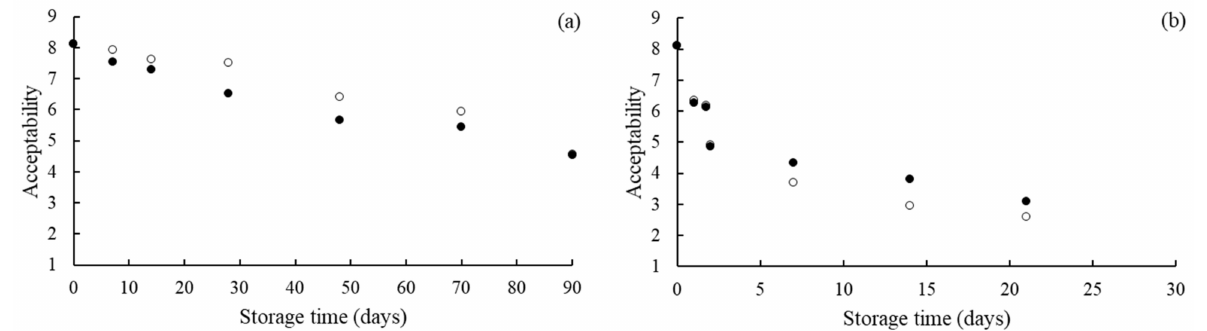
Figure 5. Consumers’ acceptability of strawberry leather during storage at 22.5% RH ( a ) and 52.3% RH ( b ), with no illumination ( • ) and with illumination (